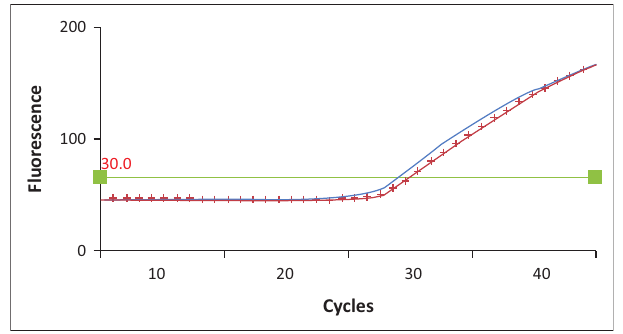
FIGURE 2: An amplification curve showing results with 0.05 µM wild-type and 0.4 µM mutant probes. Mutated allele curve with no markers, wild-type allele curve with